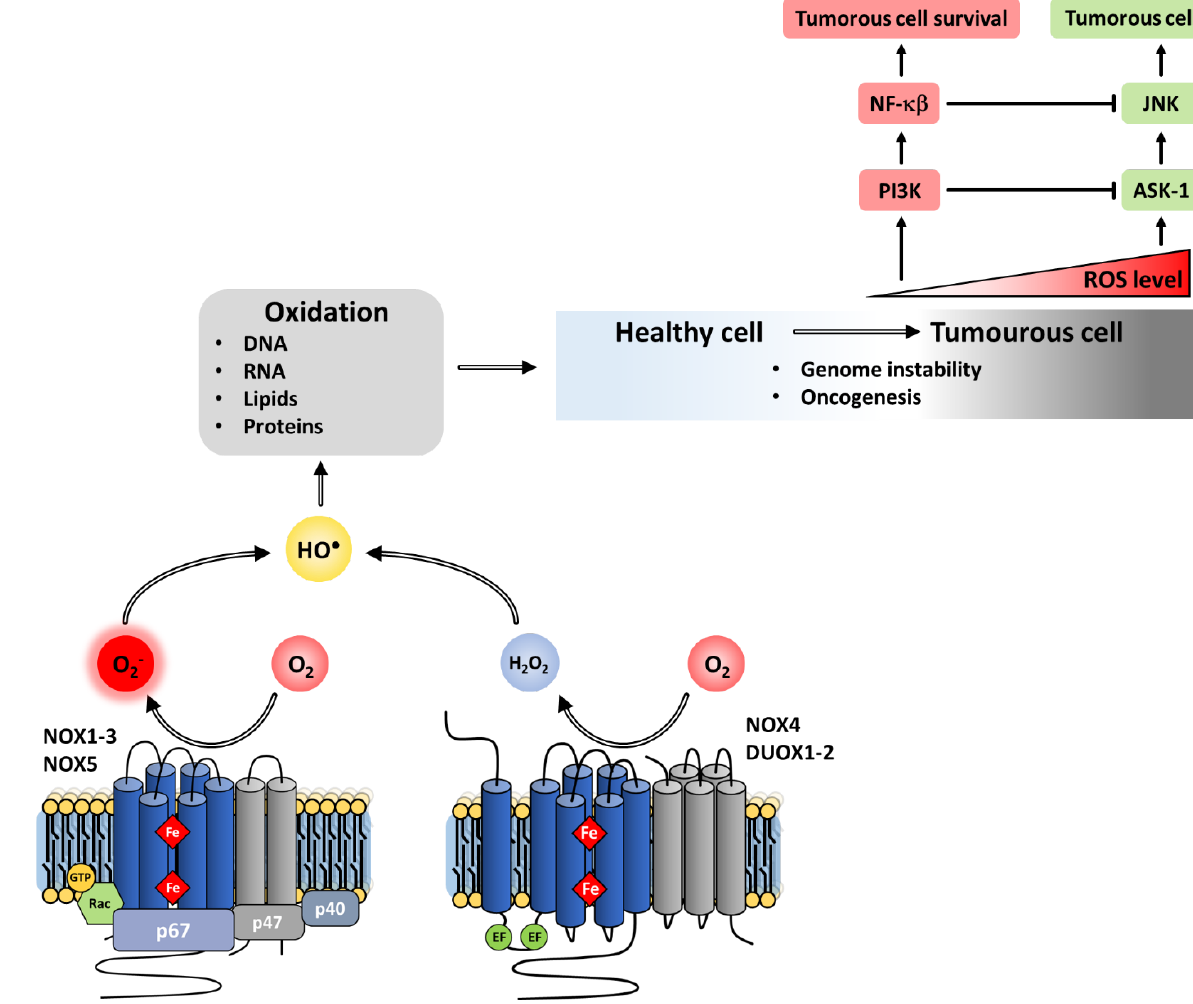
Figure 20. Endogenous sources of ROS and overproduction-related consequences. The overproduction of superoxide anions and H2O2 by NOX enzymes and the subsequent increase in hydroxyl radical levels through Fenton and Haber–Weiss reactions lead to oxidation of lipids, proteins and DNA, and consequently promotes genomic instability, high mutation rate and carcinogenesis. Under these conditions, cell survival or cell death, respectively, depend on the activation of the PI3K or Ask-1 signaling pathways. High levels of ROS stimulate the Ask-1/JNK pathway, leading to cell death, while lower or transient levels of ROS may activate PI3K kinases and Ask-1/JNK inhibition, thus ensuring NF- κβ -mediated cell survival [385]. Inspired by [385].